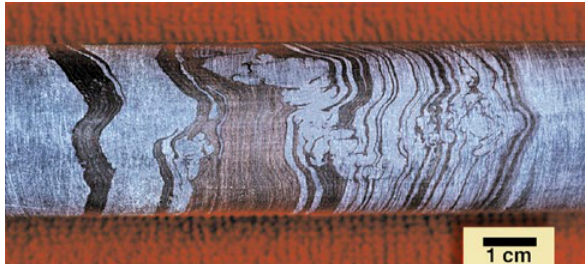
Figure 30. A ptygmatic mud dike is injected into hematite shale at the soft sediment stage. The highly fluid nature of mud betwe- en haematite layers is indicated by the irregular folding in its bed- ding but the dike which has broken across the soft bands is highly contorted into a ptygmatic pattern due to the rheology of the non- Newtonian fluid paste. (From Explorer 8 core, Tennant Creek, NT).